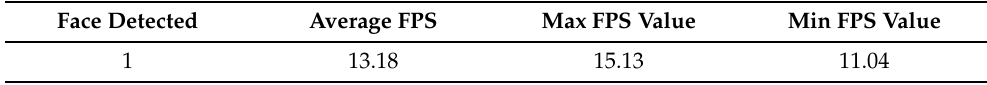
Table 15. System performance in ROS with max_num_faces: 1.